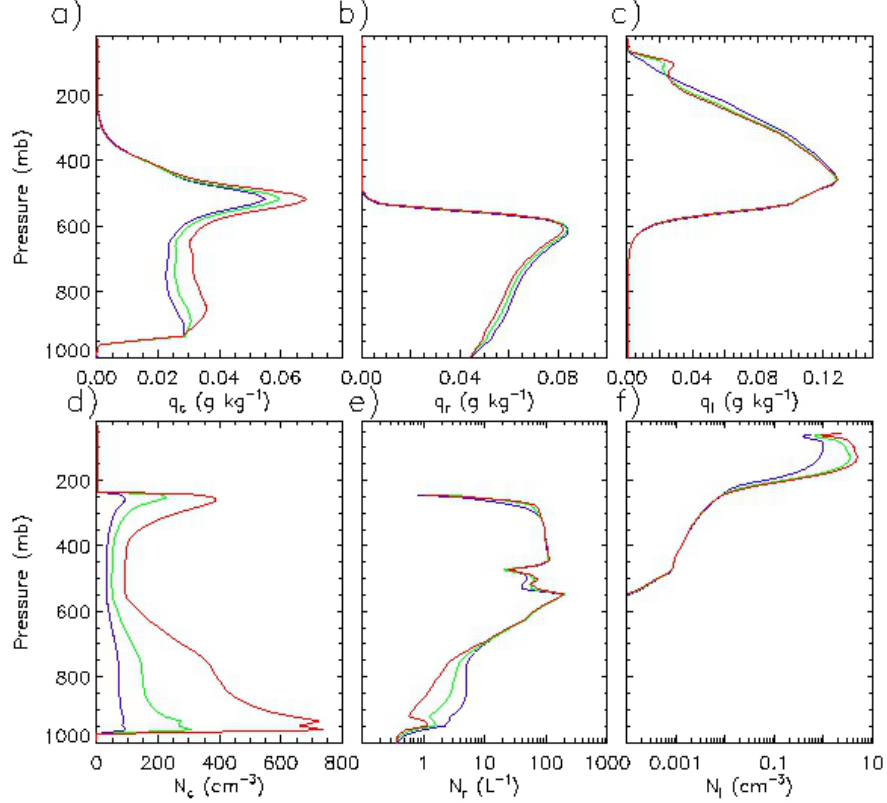
Fig. 13. Profiles of ensemble- and horizontally-averaged (a) cloud water mixing ratio, q c , (b) rain mixing ratio, q r , (c) ice mixing ratio, q i , (d) cloud droplet concentration, N c , (e) rain number concentration, N r , and (f) ice number concentration, N i , for PRIS (blue), POLL (green), and SPOLL (red). Presented results are averaged between 12:00UTC 19 January to 12:00UTC 25 January. Number concentrations are averaged over grid cells with mixing ratio greater than 0.001gkg − 1 for the given hydrometeor species.